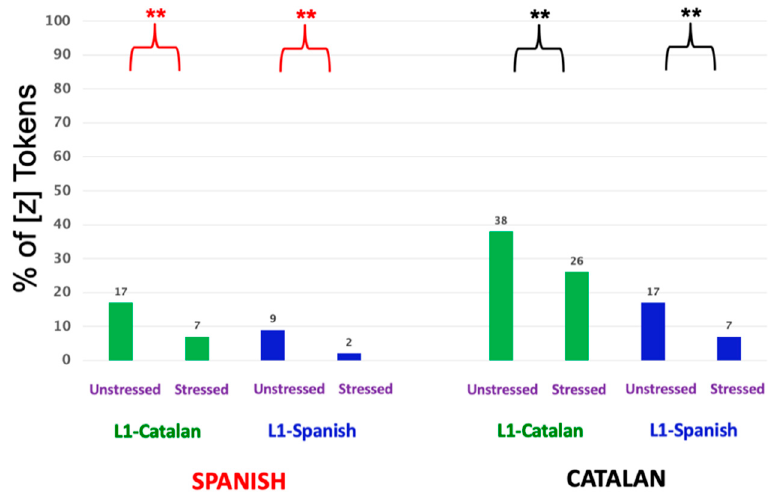
Figure 15. Effect of stress as mediated by language profile and language on Valencian fricative production.